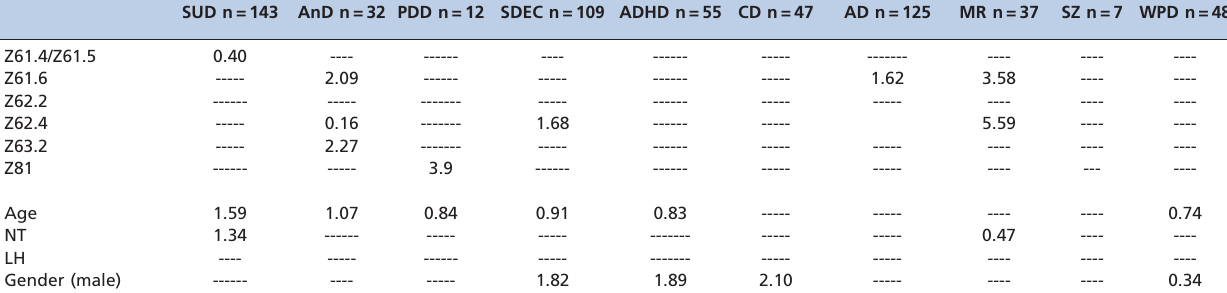
Table 3 - Psychiatric diagnosis*** and associated conditions according to logistic regression model**** (odds ratio) (n=